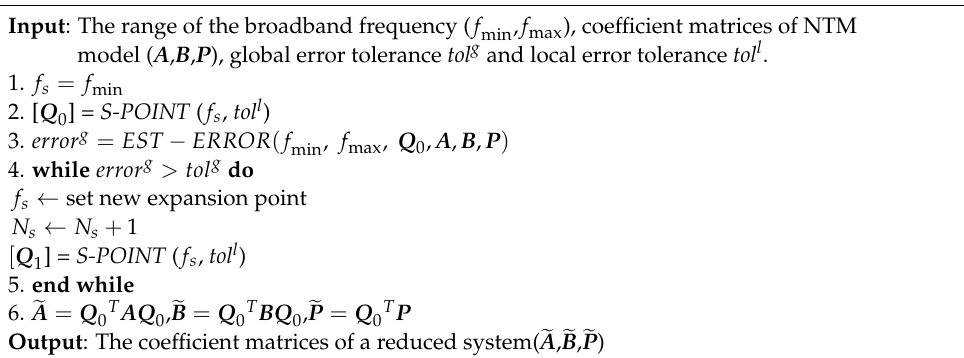
Algorithm 1. Main loop of the proposed scheme for 3-D transient field problems